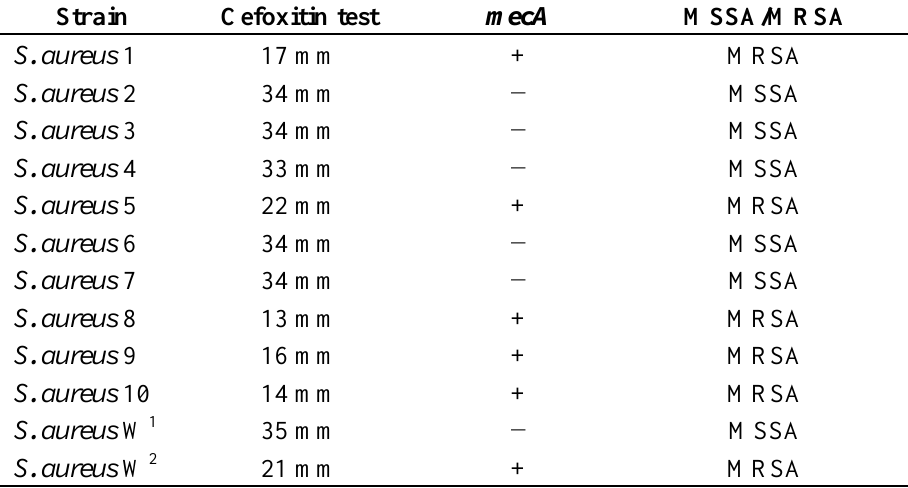
Table 1. The phenotypic (Cefoxitin test) and genetic (PCR mecA gene) assessment of S. aureus strains susceptibility to methicillin.